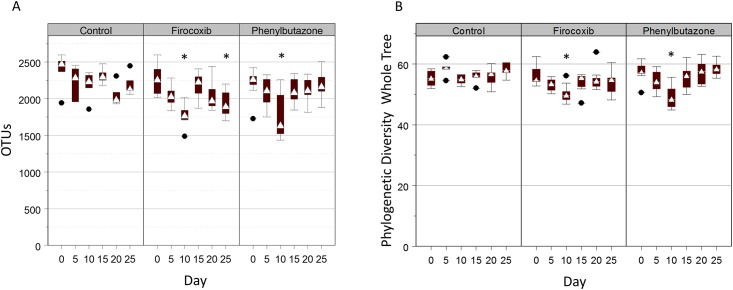
NSAID administration results in a temporary decrease of richness and alpha diversity of the fecal microbiota.A) Numbers of OTUs by day of treatment. White triangle = median; bottoms and tops of boxes are 25th and 75th percentiles, respectively. Whiskers extend to a fixed multiple of the interquartile distance, and black circles with horizontal lines are outliers. B) PD whole tree diversity index by day of treatment. White triangle = median; bottoms and tops of boxes are 25th and 75th percentiles, respectively. Whiskers extend to a fixed multiple of the interquartile distance, and black circles with horizontal lines are outliers. Data were analyzed with generalized linear models with the dependent (outcome) variables of number of OTUs or phylogenetic diversity (PD) whole tree index; independent variables of time, group, and their interaction were modeled as fixed categorical variables (ordered in the case of time) and individual horse was modeled as a random effect. Post hoc multiple comparisons among groups and times were adjusted using the method of Sidak. Asterisks above the bar represent significant differences as compared with day 0.